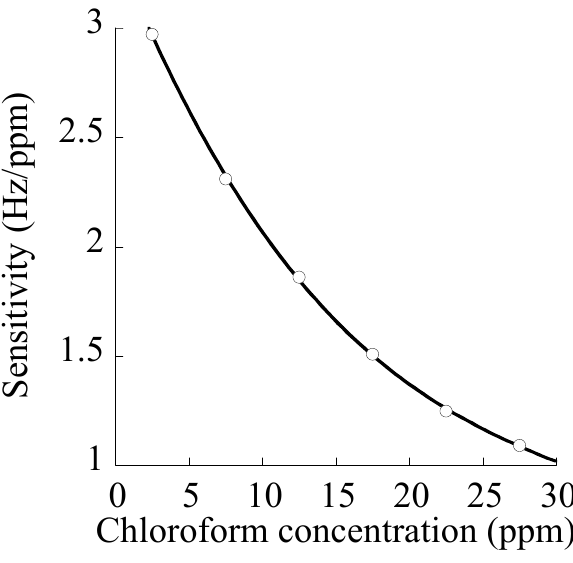
Figure 14. Plot of experimental and theoretical sensitivity (solid line) as a function of chloroform concentration in aqueous solution.